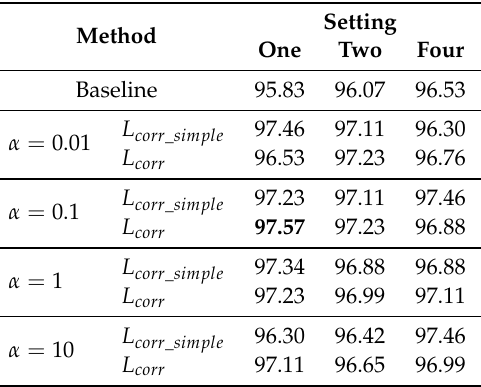
Table 6. The performance of audio-visual emotion recognition with different settings on the RAVDESS